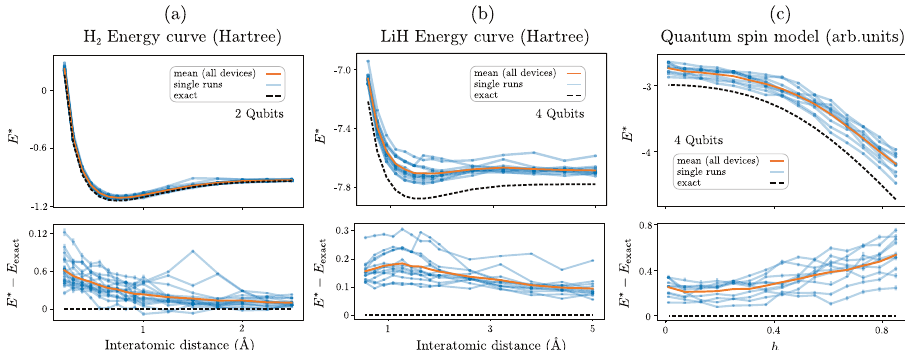
Fig. 3 Experimental application of VQE + BOIS running on IBMQ devices. Final energy estimates E * (top) and fi nal errors ( E * − E exact ) (bottom) are plotted for three different problems. Repeated runs (blue curves), executed on a set of different devices 28 , show the distribution around the mean (orange curves). a H 2 dimer showing eighteen separate VQE + BOIS (all-to-all) runs. Each ran for ten iterations with thirty (shared — see “ Practicals aspects of Bayesian optimisation ” in the “ Methods ” section) initial points. b LiH dimer showing thirteen separate VQE + BOIS (all-to-all) runs. Each ran for thirty iterations with thirty (shared) initial points. c Quantum spin model, Eq. (1) with h (considered in “ Testing the effectiveness of information sharing ” ) showing ten separate VQE + BOIS (nearest-neighbour) runs. Each ran for fi fty iterations with ten (shared) initial points. Error bars indicate standard error on fi nal energy